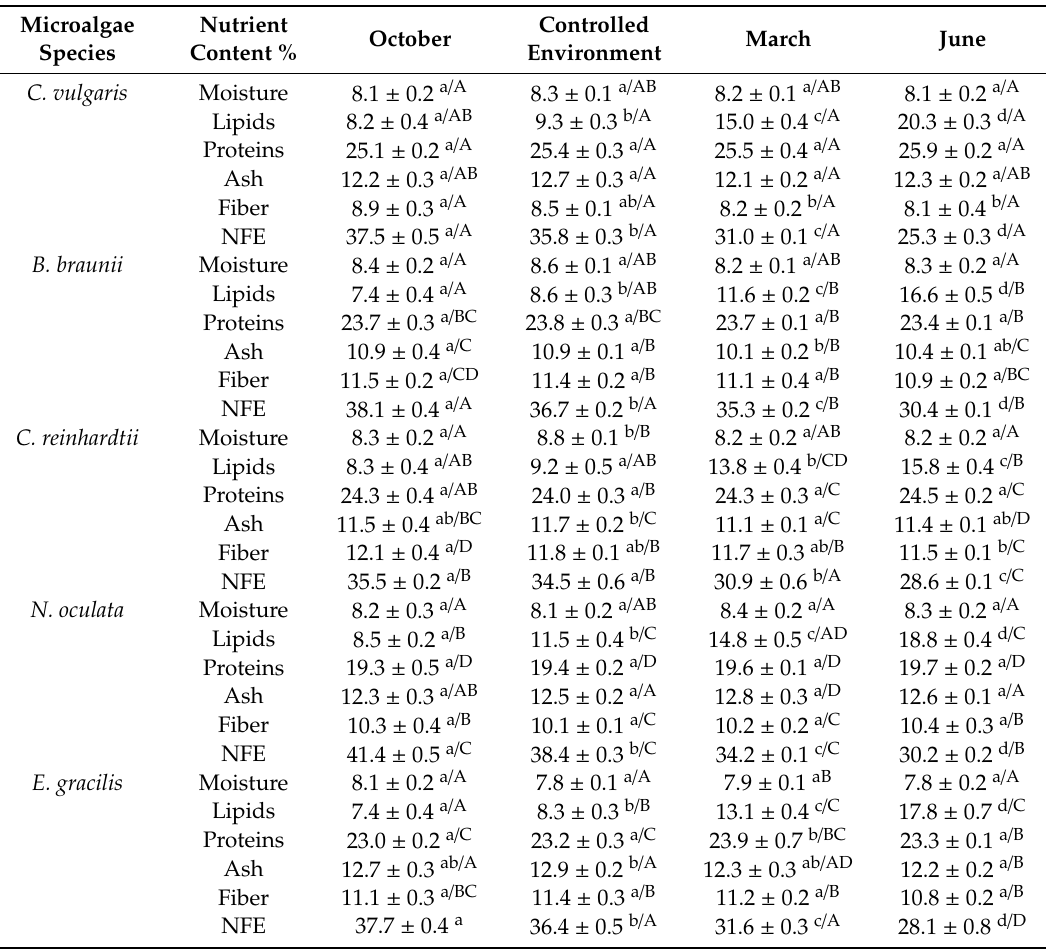
Table 2. Nutrient content (%) of the five microalgae species cultivated in the four di ff erent environmental